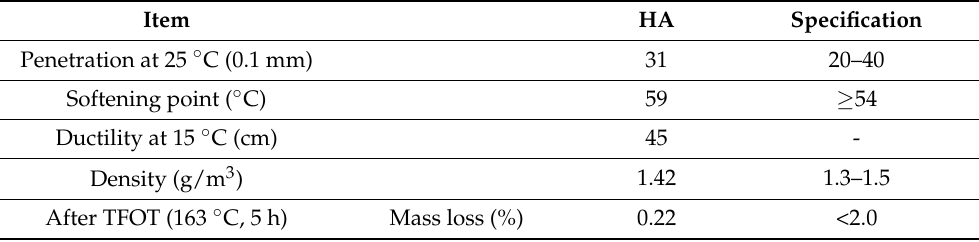
Table 6. Typical characteristics of used hard asphalt binder. Table 7. Asphalt contents of the three